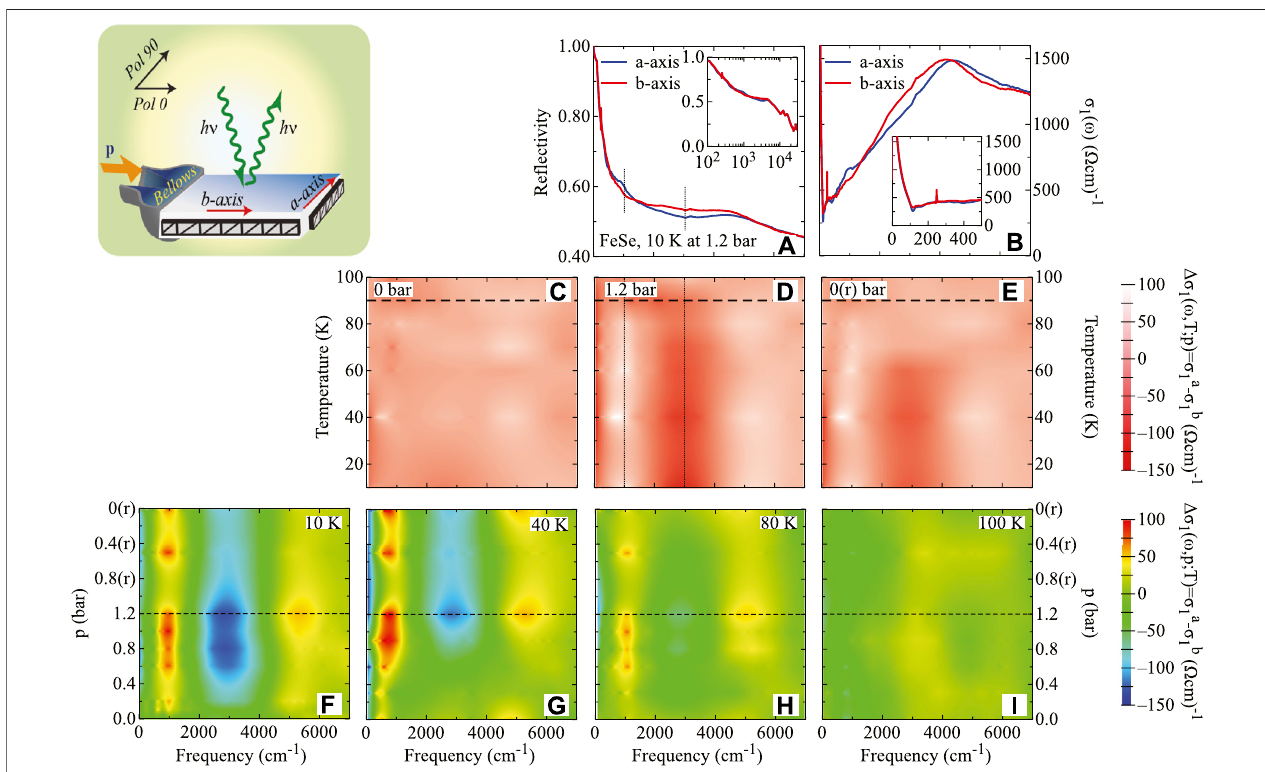
FIGURE 2 | (color online) Experimental setup as well as T and p dependence of the optical anisotropy in FeSe: The upper-left panel schematically shows a sample inside the mechanical device and emphasizes the orientation of its a - and b -axis with respect to the direction of the applied stress p . Polarized light parallel to the orthorhombic (elongated) a - and (short) b -axis (in our experimental set-up Pol 90 and Pol 0, respectively) illuminates the sample (see details in Figure 1 ). (A) Representative data of the optical re fl ectivity ( R ( ω )) of FeSe at 10 K and 1.2 bar (i.e., at saturation) after a ZPC experiment; it emphasizes the optical anisotropy at MIRfrequencies(1 eV=8.06548×10 3 cm − 1 )[25].Theinsetshows R a ( ω )and R b ( ω )fromtheFIRuptotheUVrangewithalogarithmicfrequencyscale. (B) Realpart σ 1 ( ω ) oftheopticalconductivityanditsblowuppertinenttotheFIRrange(inset)at10 Kand1.2 bar. (C – E) T dependenceofthedichroismde fi nedas Δ σ 1 ( ω ) (cid:2) σ a 1 ( ω ) − σ b 1 ( ω ) at 0, 1.2 and released 0 bar after the ZPC p -loop experiment. The thick horizontal dashed line marks T s . The thin vertical dotted lines in panels (A) and (D) mark the frequencies 1,000 and 3,000 cm − 1 . (F – I) Δ σ 1 ( ω ) at selected T below and above T s within each ZPC p -loop experiment. The thin horizontal dashed line marks p at saturation. A fi rst-neighbor interpolation procedure is used in order to generate the color maps. Released p is denoted by “ (r) ” . Reproduced from Ref.